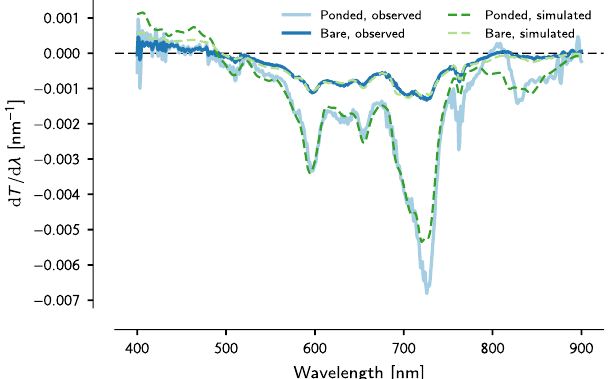
Figure 6. Mean gradients (d T/ d λ ) of simulated and observed spec- tra, for bare and ponded ice. Only locations that are identified as being away from pond edges are